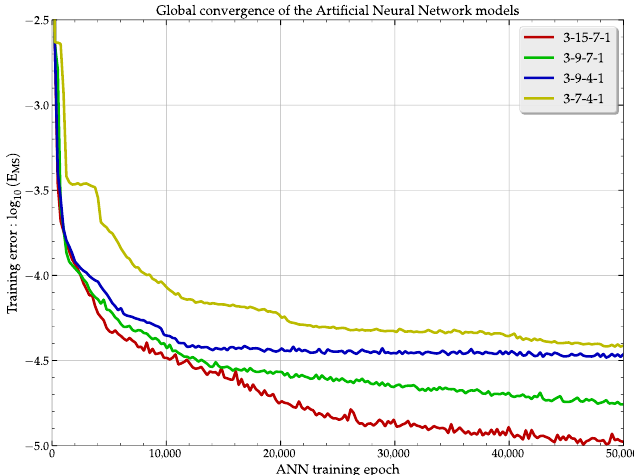
Figure 3. Convergence of the ANN models during the training phase.